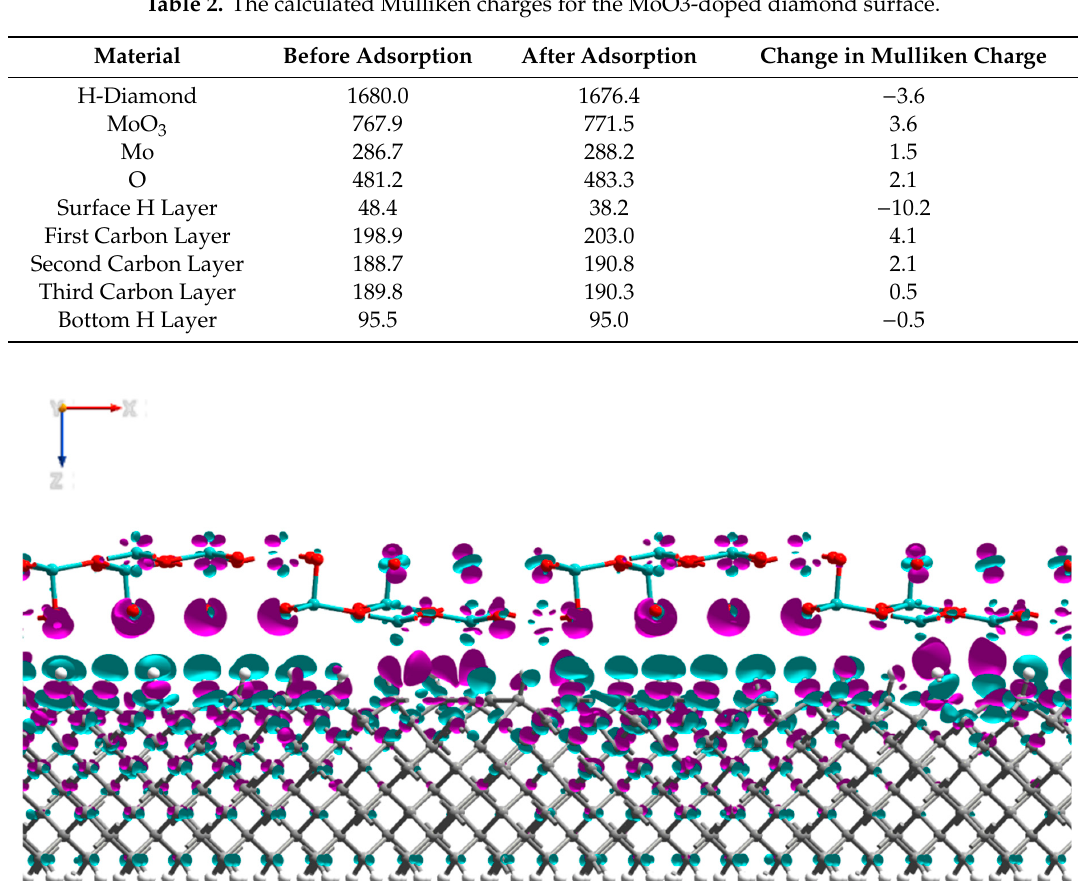
Figure 7. Side view of the MoO 3 :H-diamond interface structure showing the electron density differences. The purple regions represent electron accumulation and the green regions represent electron depletion (hole accumulation). The isosurface values are ±0.002 Bohr − 3 .